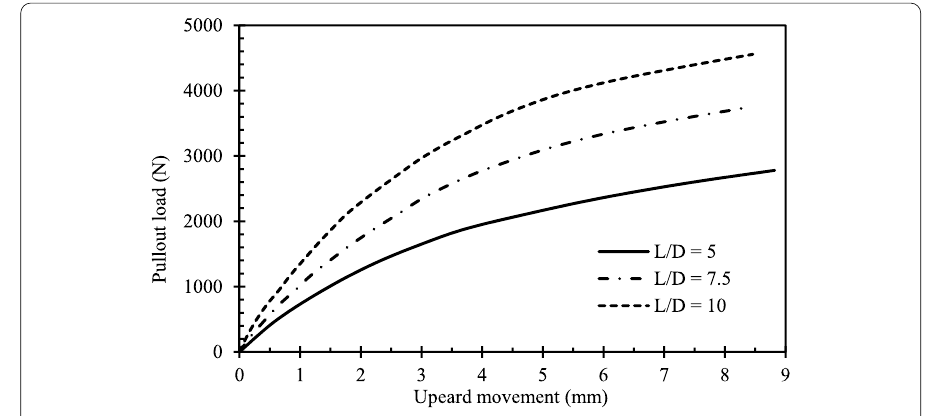
Fig. 6 Pullout behaviour of 75 mm diameter GPA